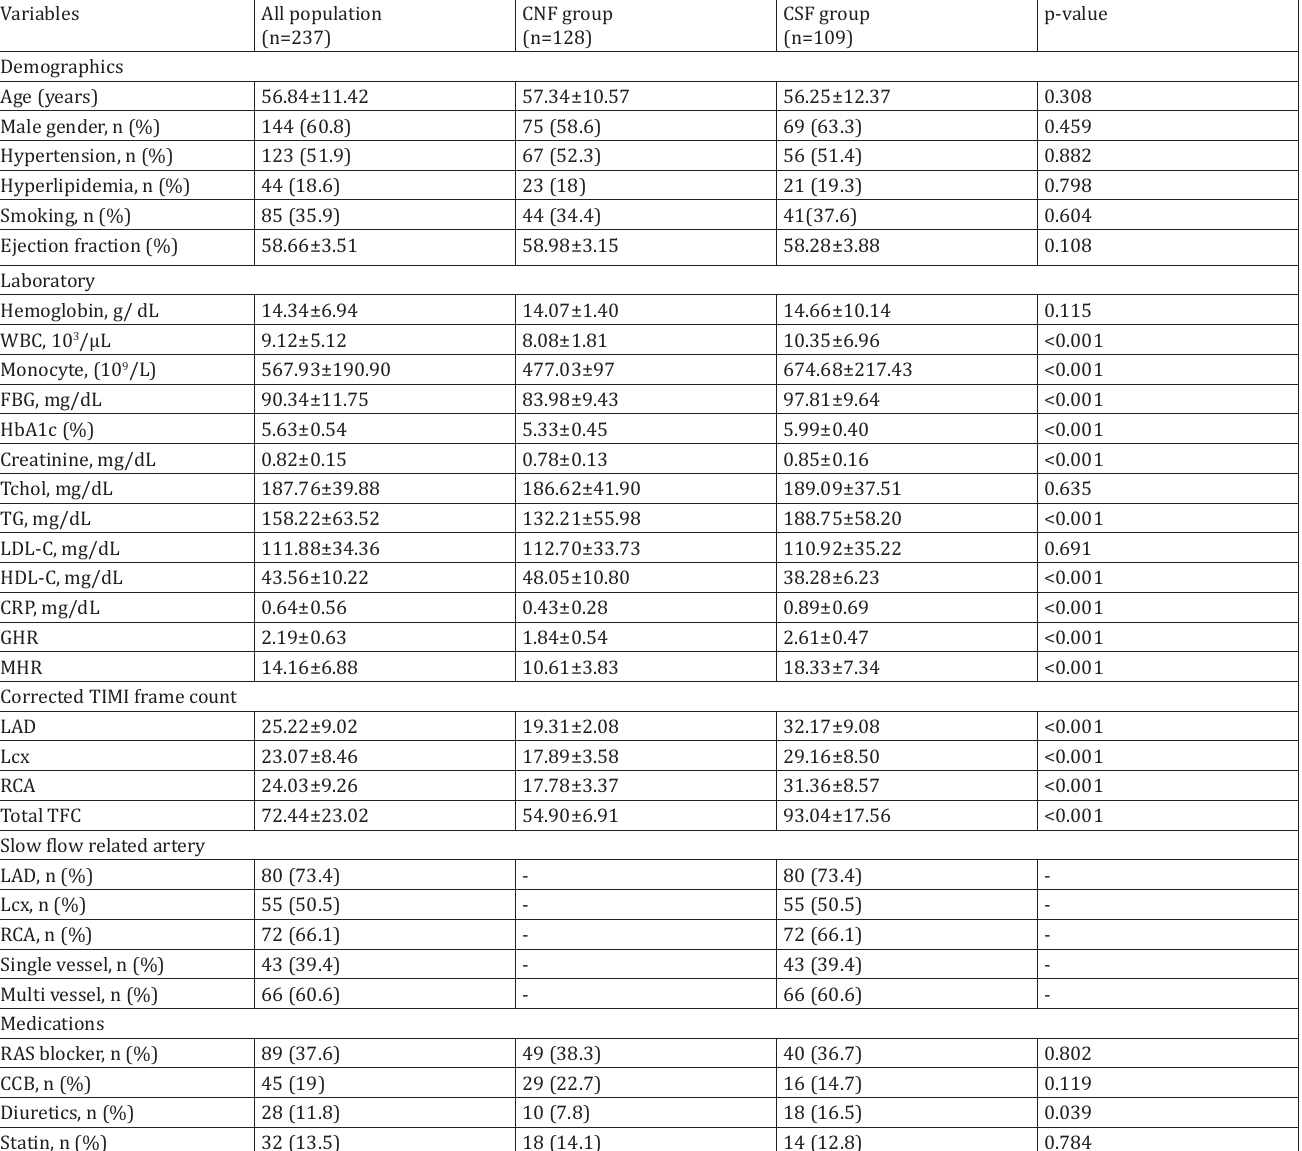
Baseline characteristics and clinical data of the study population